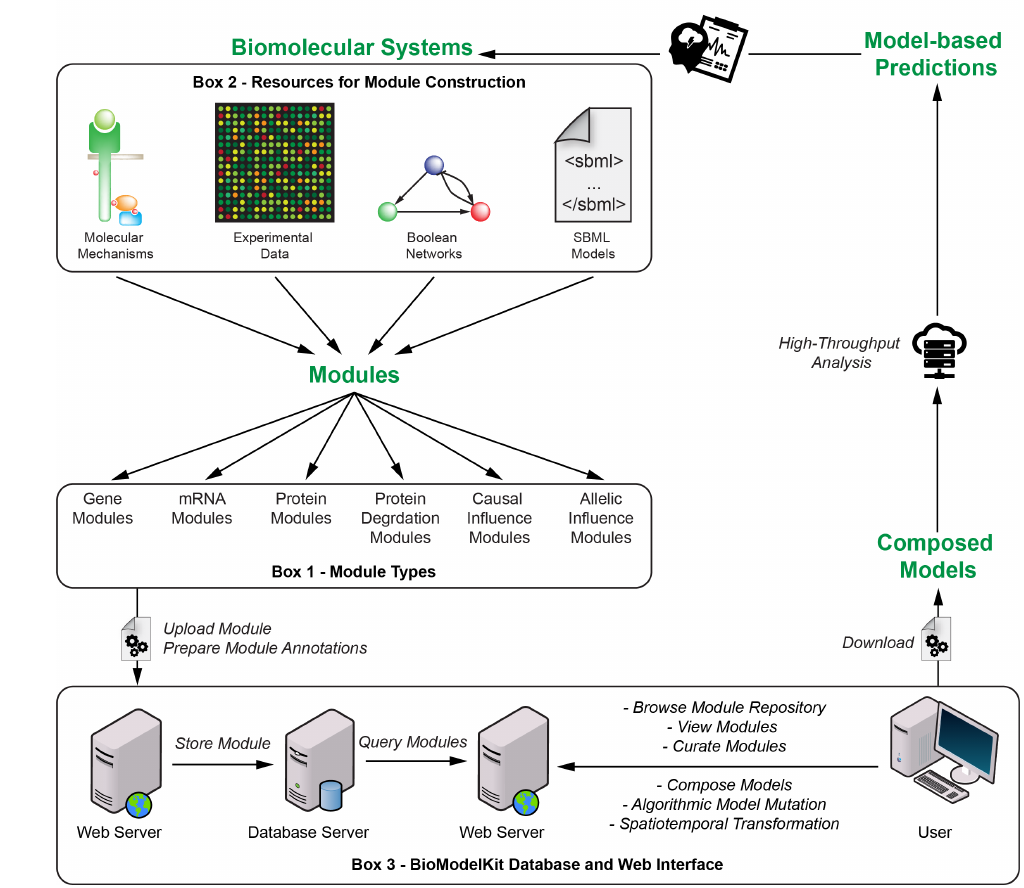
Figure 2: Overview of the BioModelKit